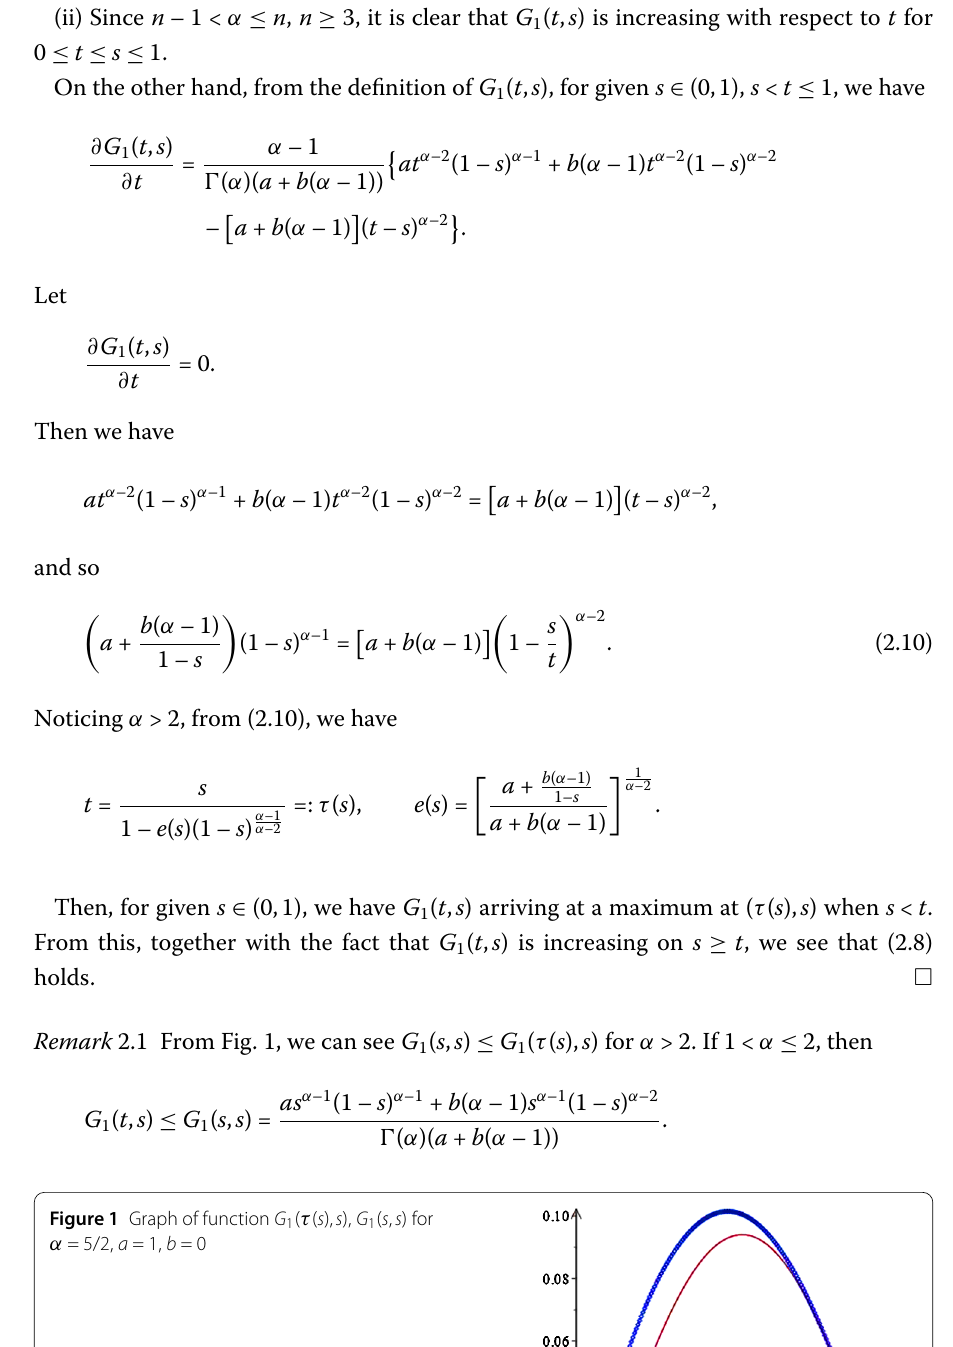
Figure 1 Graph of function G 1 ( τ ( s ), s ), G 1 ( s , s ) for α = 5/2, a = 1, b =